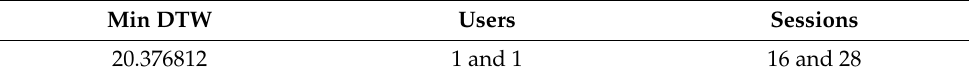
Table 4. Pairwise DTW normalized cumulative distance calculation result—the same